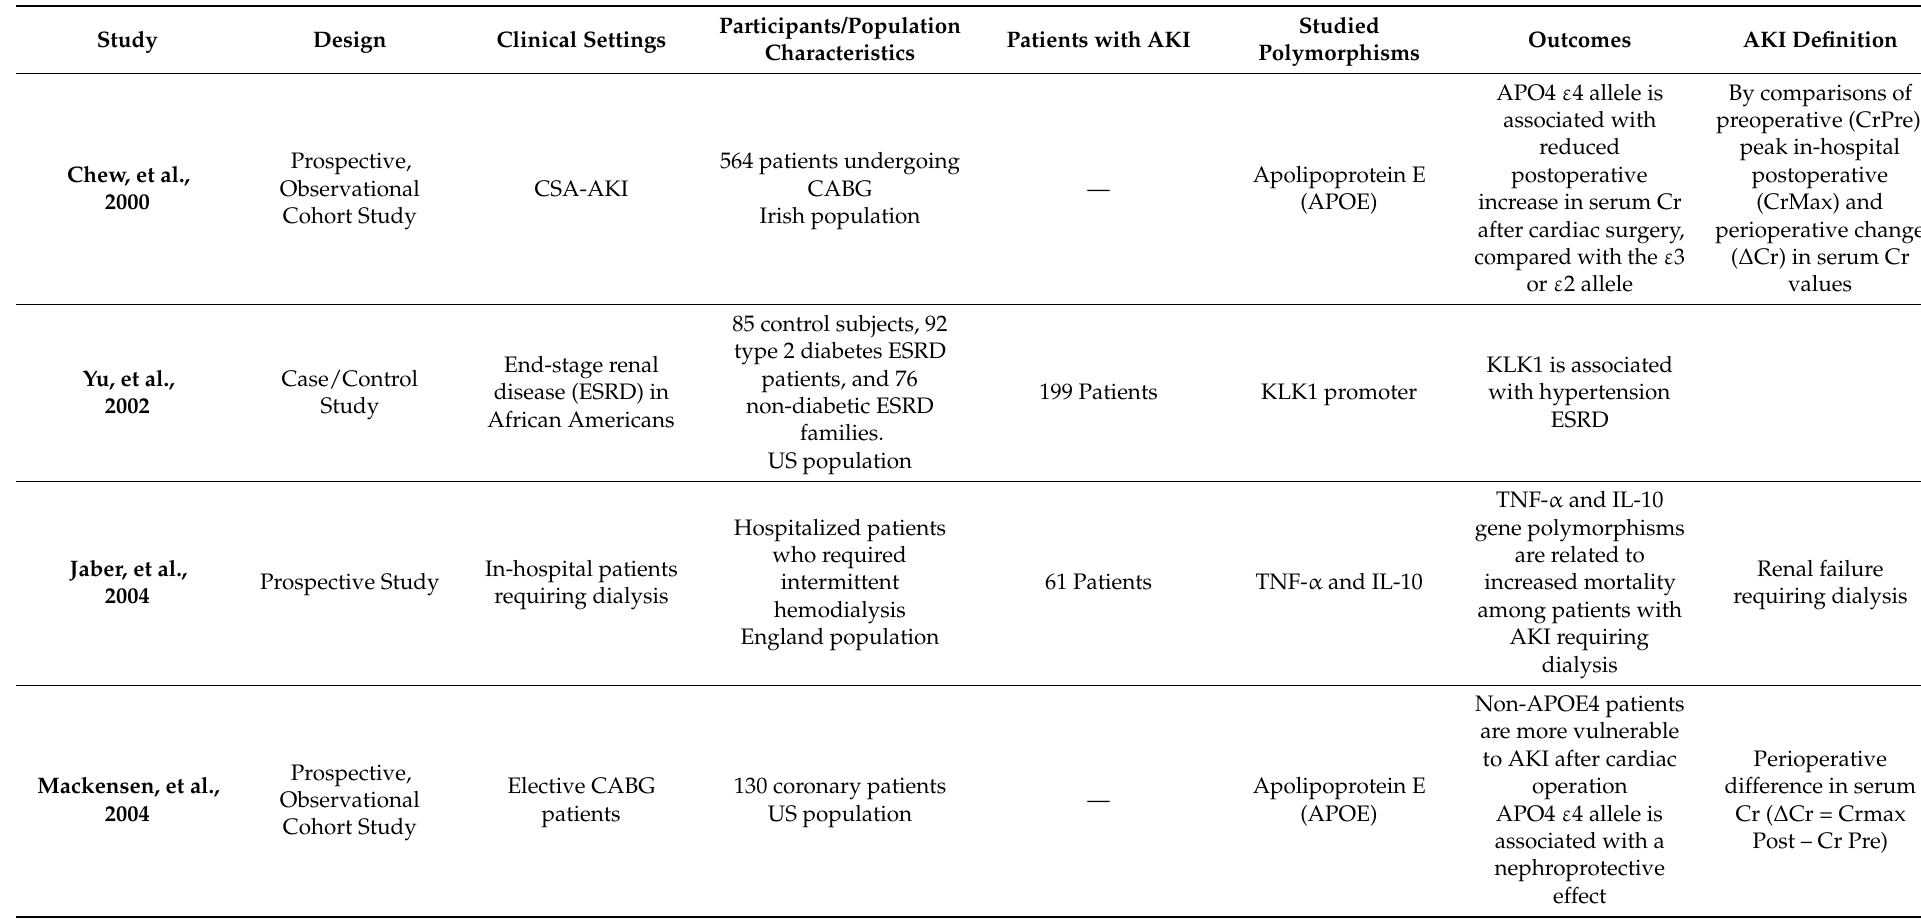
Table 1. AKI susceptibility studies with their investigated gene polymorphisms along with their related evidence presented